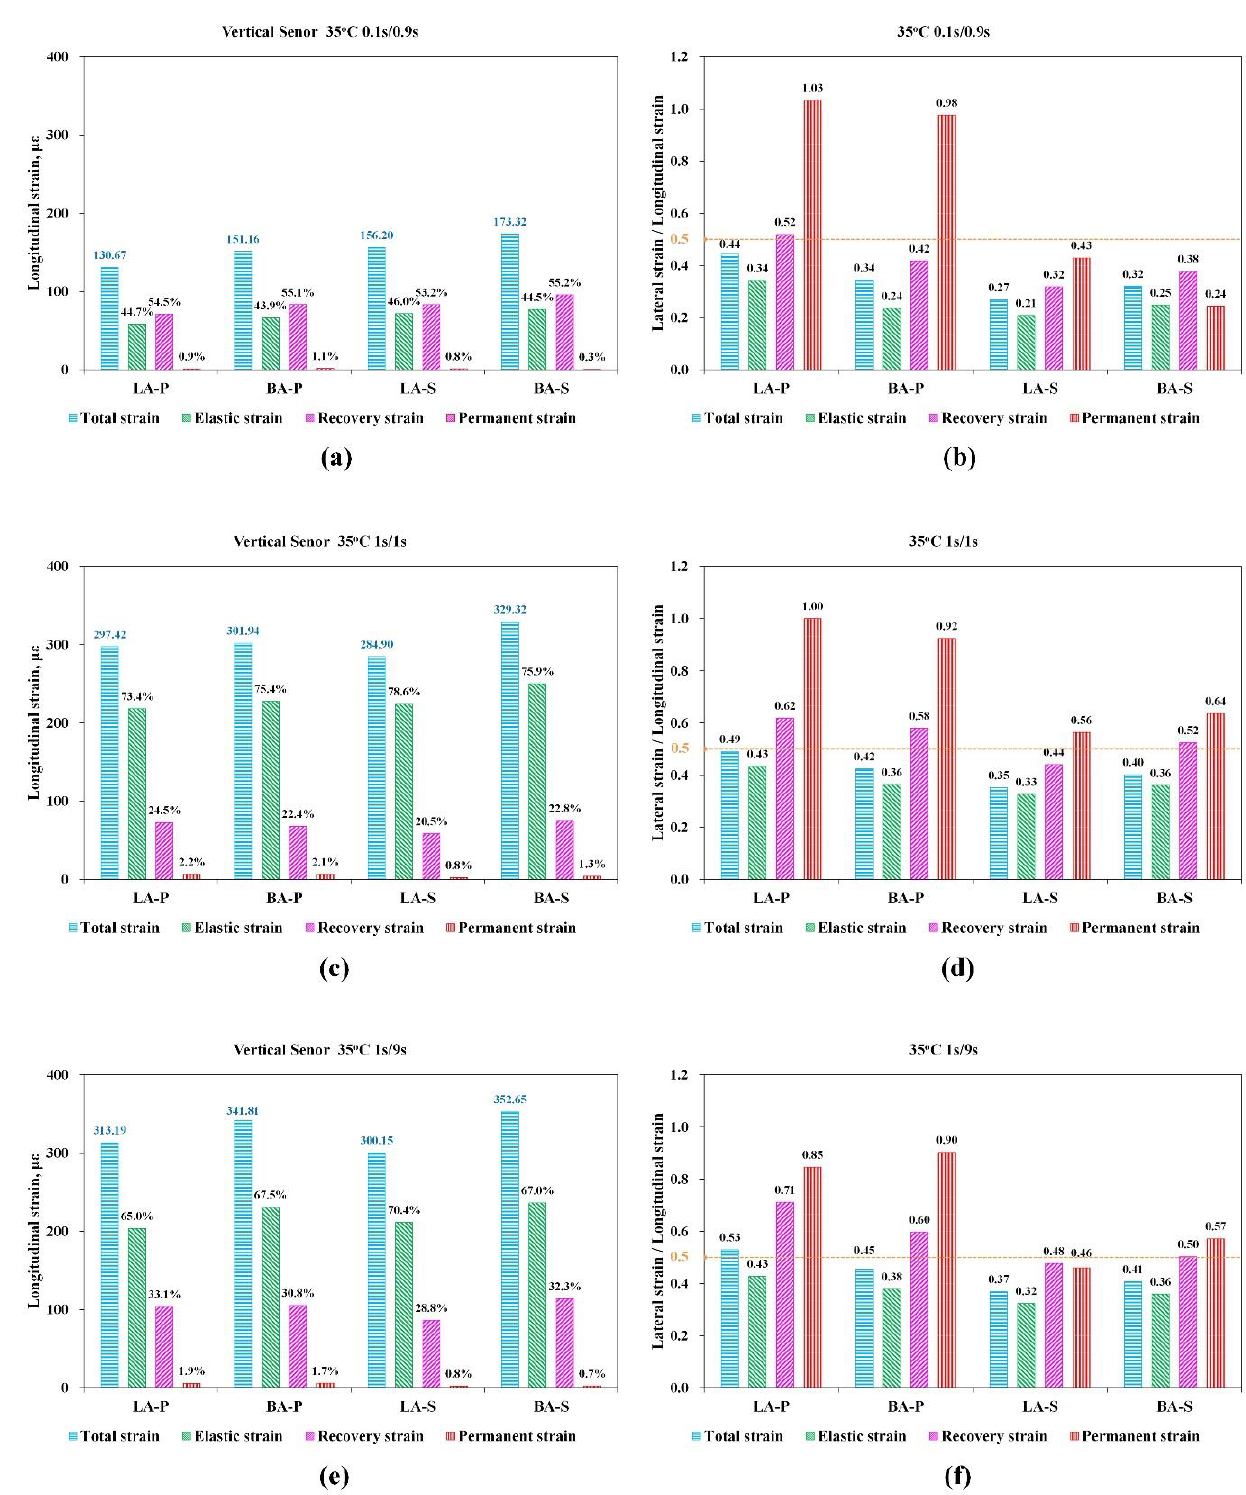
Figure 9. The longitudinal strain and the corresponding lateral/longitudinal strain ratios at the loading/rest time combinations of 0.1 s/0.9 s (( a , b )), 1 s/1 s (( c , d )), and 1 s/9 s (( e , f )) at 35 °C.